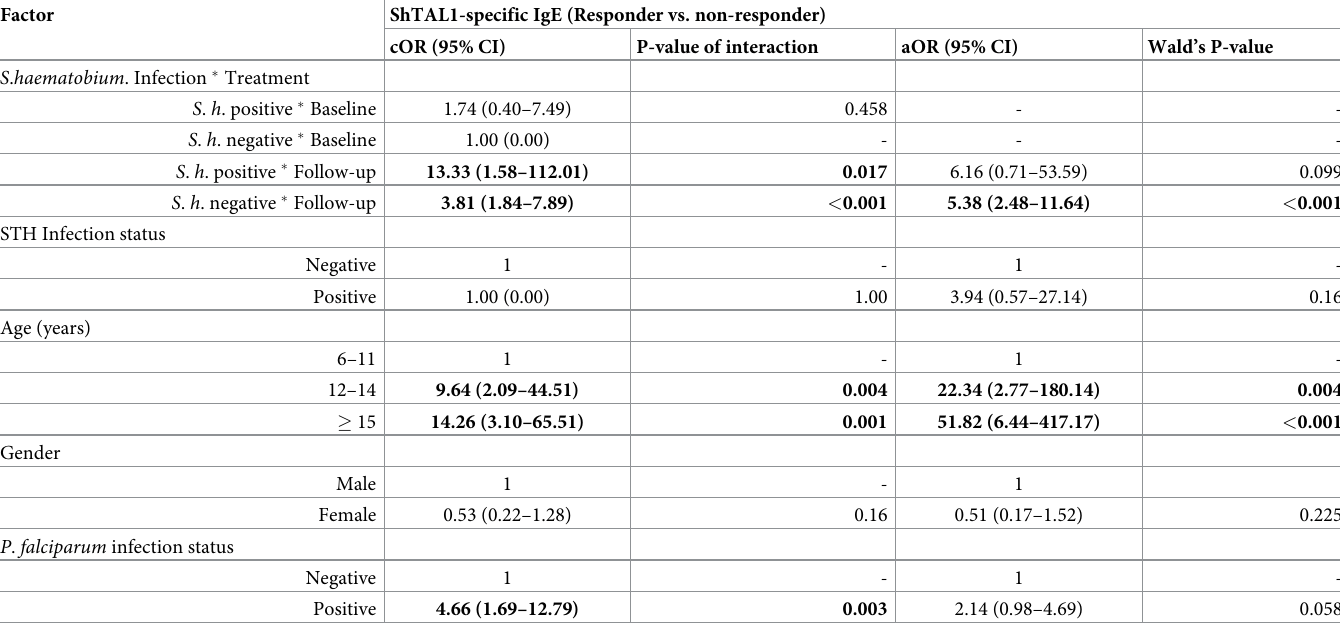
Table 3. Factors associated with changes in ShTAL1 IgE response over the study